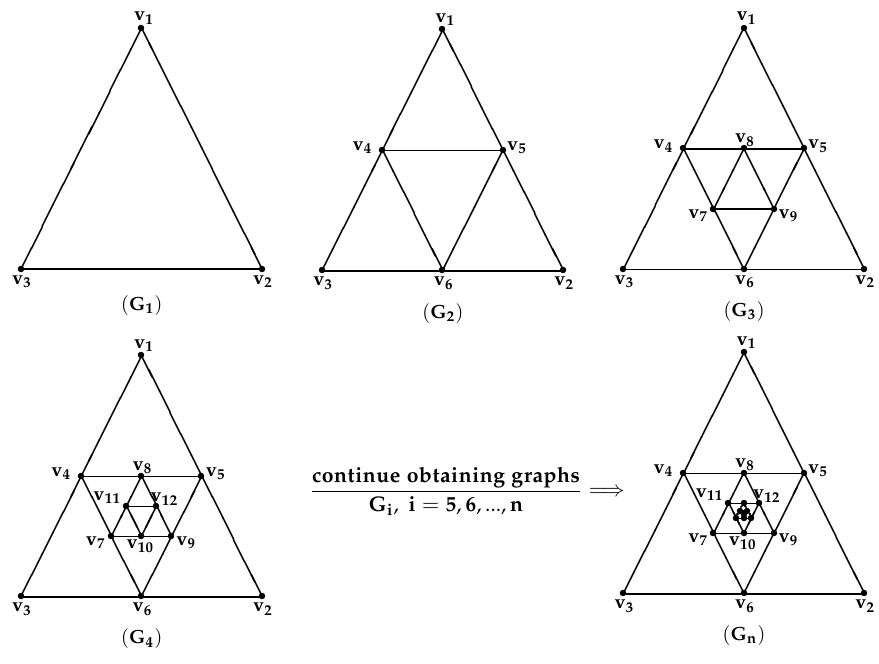
Figure 3. Structures of graphs G 1 , G 2 , G 3 , G 4 ..., G n of orders 3, 6, 9, 12, ..., 3n.